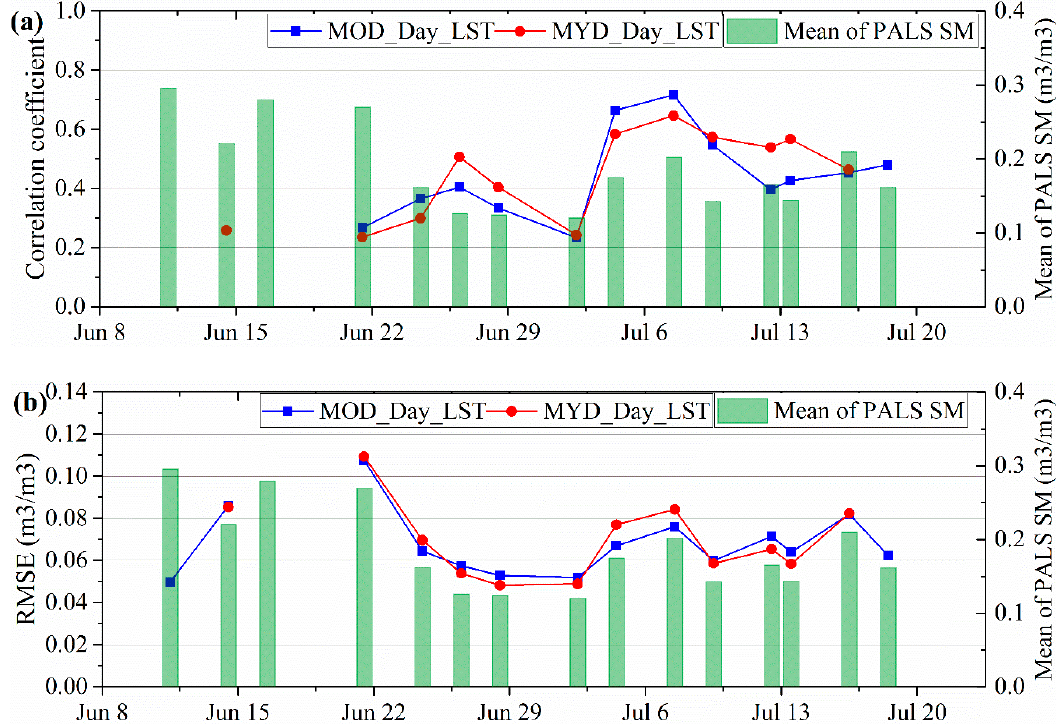
Figure 11. Results of evaluating LST as a downscaling factor. ( a ) and ( b ) are the Pearson correlation coefficient and RMSE (m 3 /m 3 ) between PALS SM and the simulated SM based on LST.